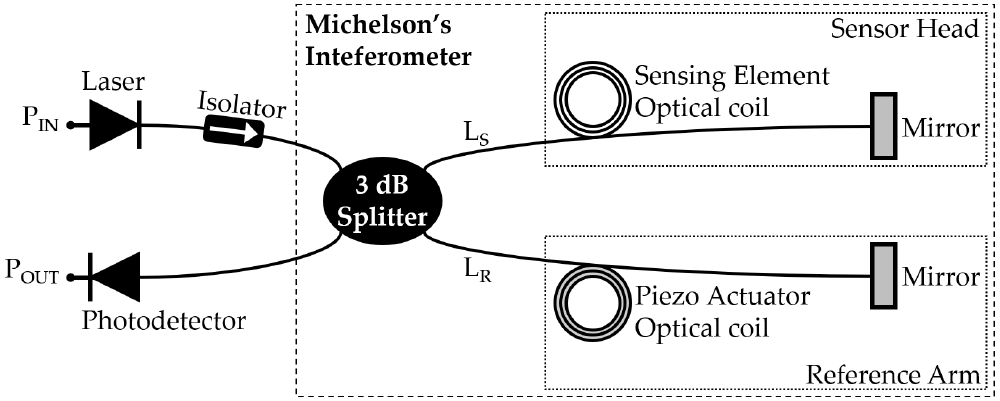
Figure 1. An FOH based on a Michelson’s interferometer.